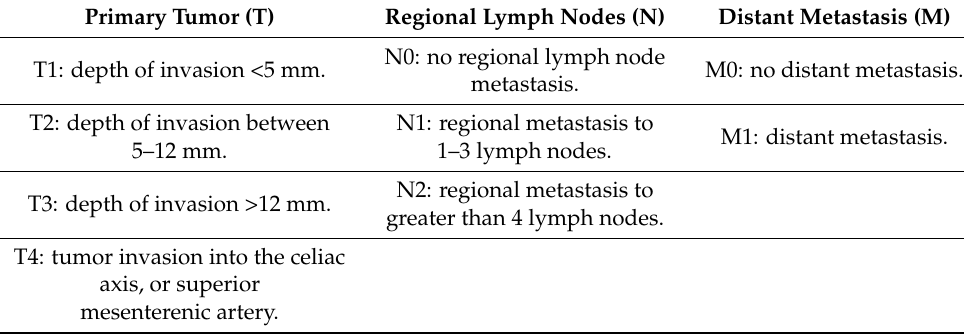
Table 3. TNM staging of distal